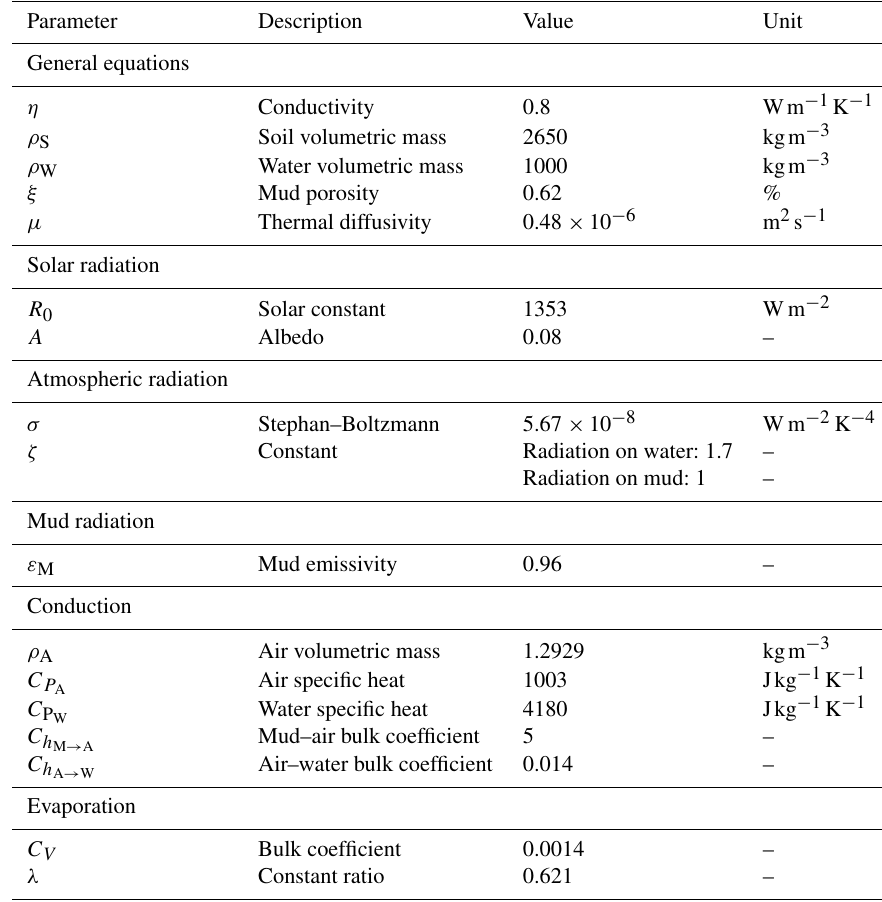
Table A2. Parameters in the mud surface temperature